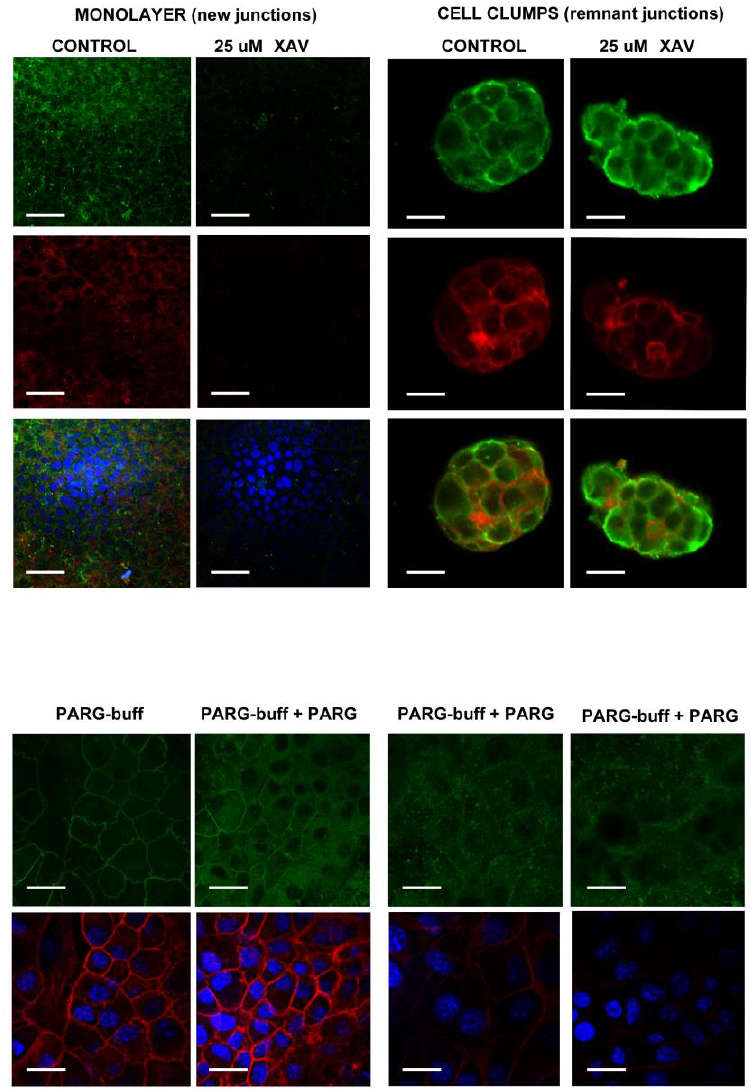
Figure A1. NMuMG cells own a PAR belt closely associated with the actin belt. Top: The tankyrase inhibitor XAV prevented PAR belt synthesis and affected the actin cytoskeleton. Cells were detached by trypsinization and pipetting as usual and then seeded in control